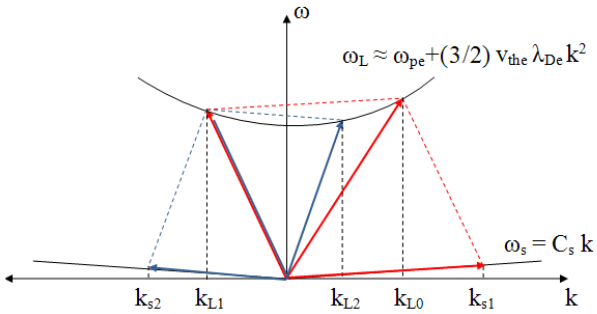
Fig. 1. Simplified schematic of the parametric decay. where k 0 = 2 C s / 3 v the λ De . Combining Eq. (14) for j = 0 with Eq. (15) gives k L1 and k s1 in terms of k L0